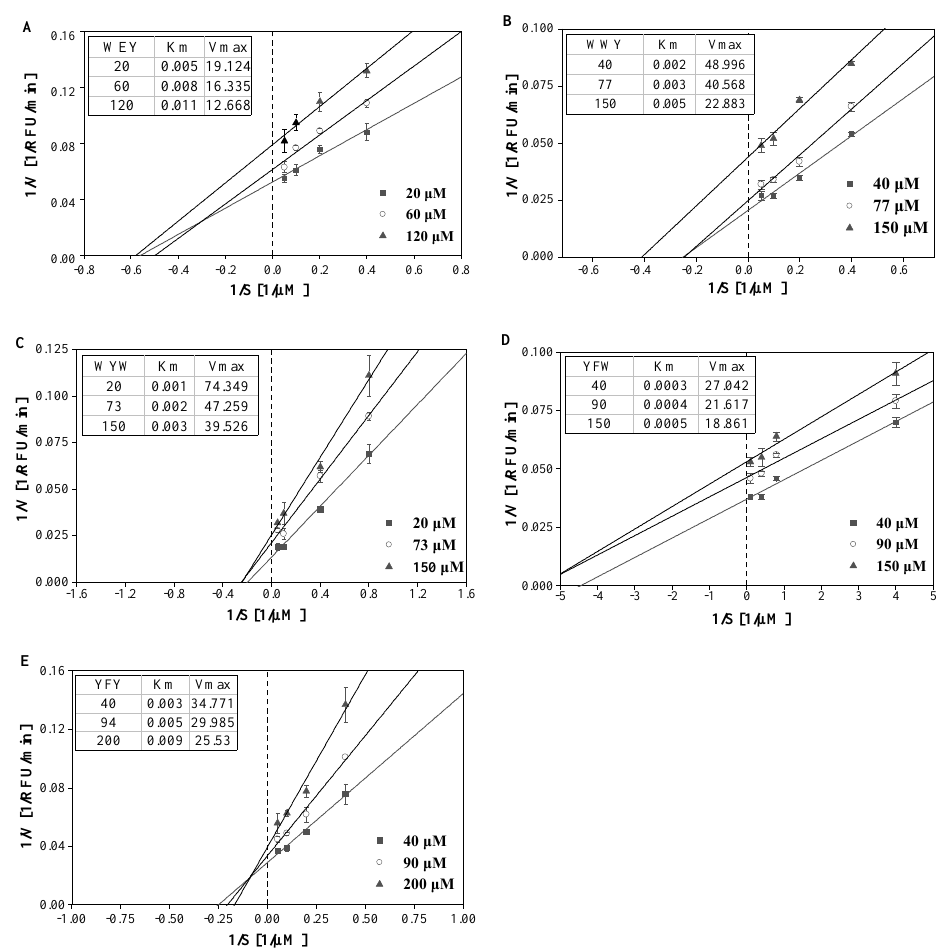
Figure 3. Lineweaver − Burk double-reciprocal plots of sEH inhibitory peptides WEY ( A ), WWY ( B ), WYW ( C ), YFW ( D ), and YFY ( E ).